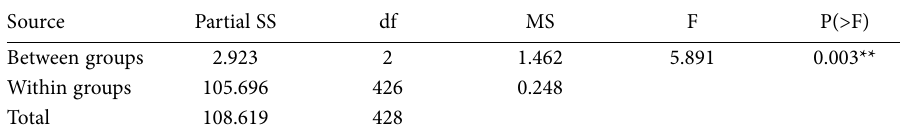
Table 9. One-factor ANOVA for the influence of sub-county on wellbeing